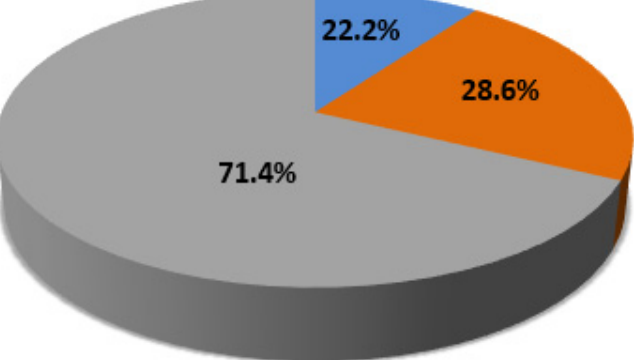
Figure 1. Graphical representation of chromosome microarray analysis (CMA) results in our group of 90 females a ff ected by autism. In the pie chart is depicted the percentage of individuals with causative copy number variants (C-CNVs), non-causative copy number variants (N-CNVs) or without copy number variants